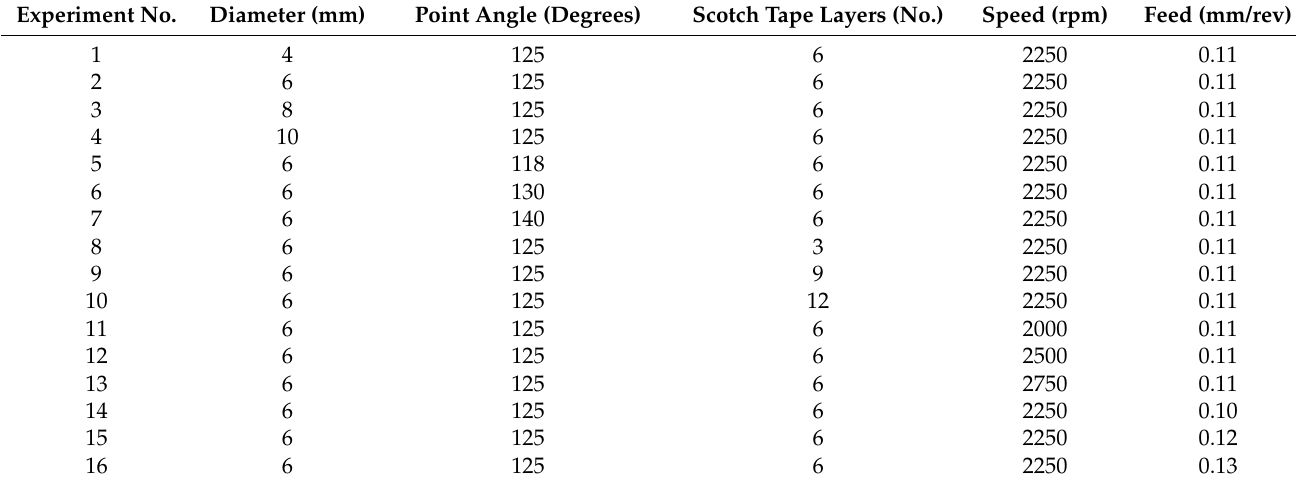
Table 1. Experimental